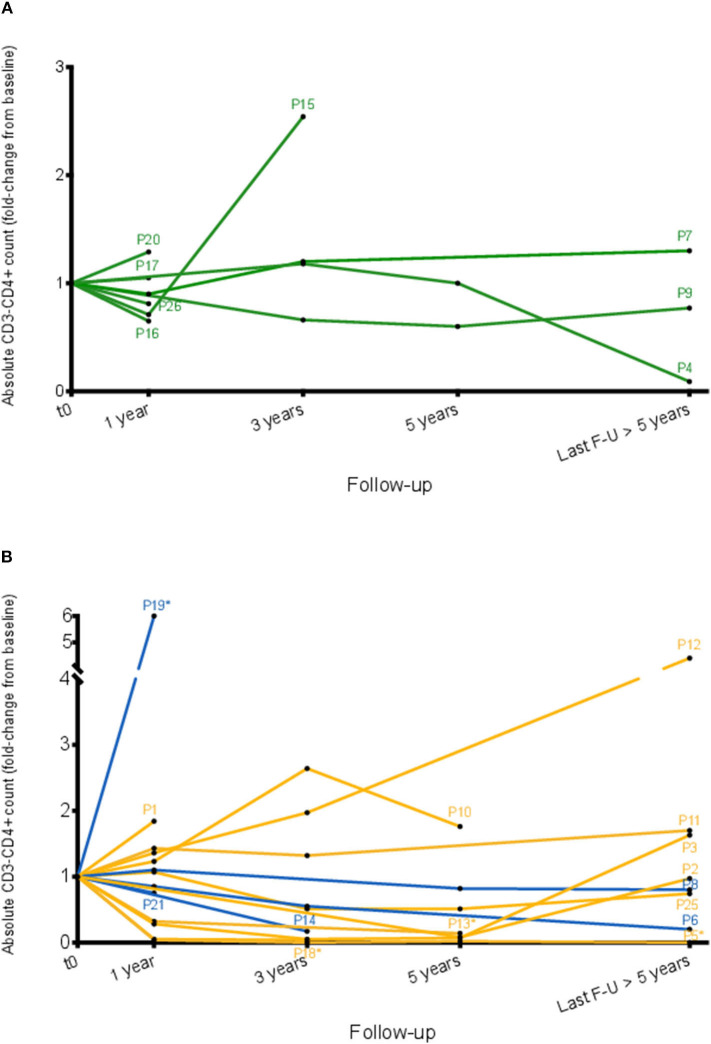
Evolution of absolute CD3−CD4+ T cell counts over time. Evolution of absolute blood CD3−CD4+ T cell counts over time is shown for all patients except P22 and P23 for whom duration of follow-up is less than a year, and P24 who is followed in another center. Absolute CD3−CD4+ T cell counts are normalized relative to baseline counts for each patient (i.e., those at initial detection of these cells), and are shown separately for untreated subjects (A) and subjects receiving treatment (B) either with oral CS alone (blue lines) or second-line therapy (yellow lines). For the three patients who developed lymphoma (P1, P2, P10) the count at last follow-up is that at the time lymphoma was diagnosed. For the other patients, the most recent CD3−CD4+ cell count and percentage, as well as the interval since first detection, are shown in Supplementary Table 7. Patients who were treated at baseline are indicated with an asterisk.